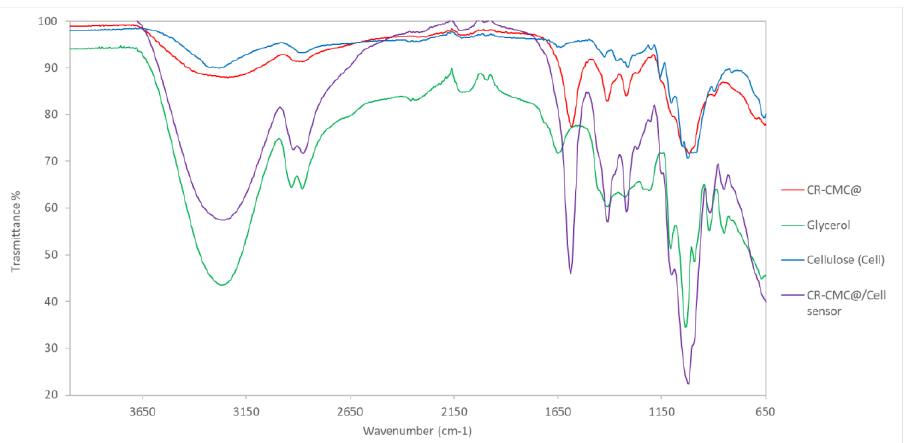
Figure 6. FT-IR spectra of CR-CMC@ (red), glycerol (green), cellulose (light blue) and CR-CMC@/Cell sensor (violet).